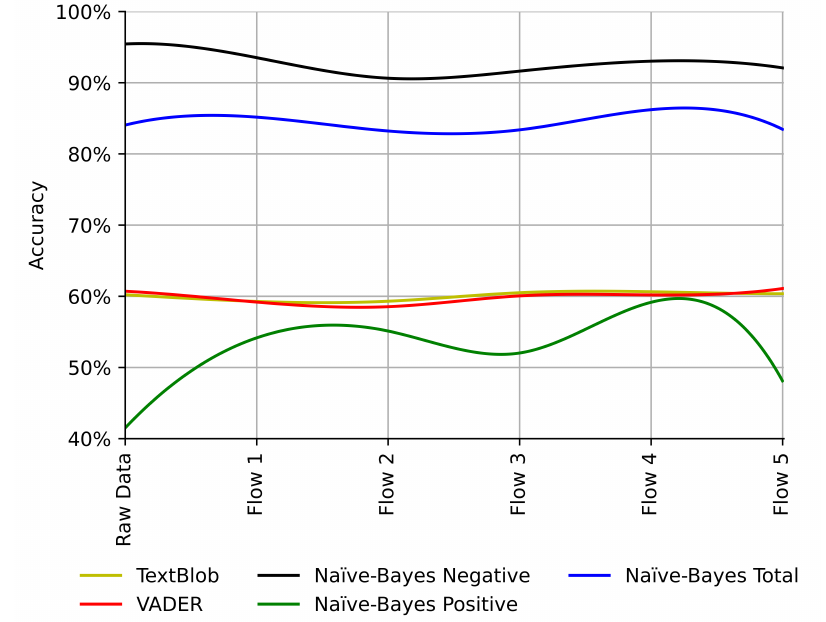
Figure 9. Accuracy of the classifiers on the entire dataset.